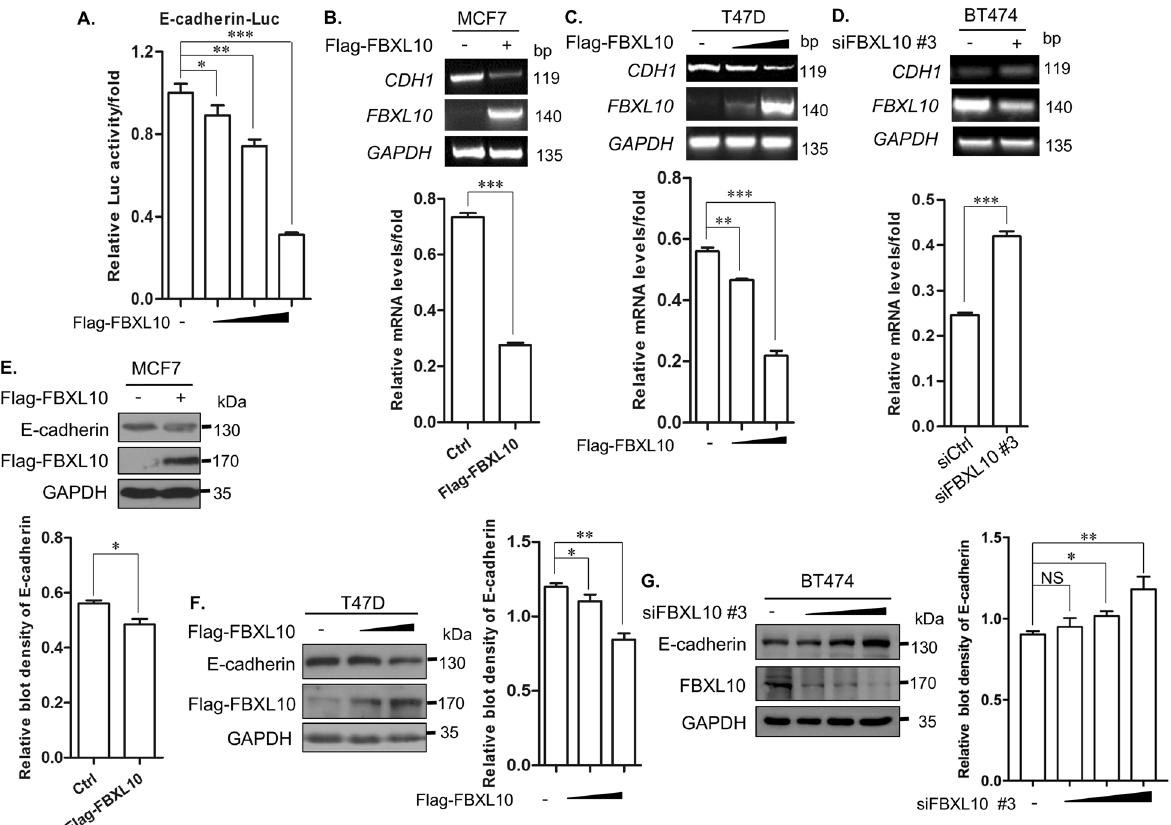
Fig. 3 FBXL10 inhibits the expression of E-cadherin in breast cancer cells. A Reporter gene assay showed the effect of FBXL10 overexpression on E-cadherin luciferase activity. B , C RT-PCR assay assessed the CDH1 mRNA levels with overexpression of FBXL10 in MCF7 ( B ) and T47D ( C ) cells. The bar graph below showed the relative intensity of CDH1 mRNA normalized by GAPDH . Data are means ± SD ( n = 3). ** P < 0.01; *** P < 0.001. D RT-PCR assay tested the effect of FBXL10 knockdown with siRNA on CDH1 mRNA levels in BT474 cells. The bar graph below showed the relative intensity of CDH1 mRNA normalized by GAPDH . Data are means ± SD (n = 3). *** P < 0.001. E , F Western blot assay was performed to evaluate the E-cadherin protein levels in MCF7 ( E ) and T47D ( F ) cells with FBXL10 overexpression. The bar graph showed the relative intensity of E-cadherin protein normalized by GAPDH. Data are means ± SD ( n = 3). * P < 0.05; ** P < 0.01. G Western blot assay evaluated the effect of siFBXL10 on E-cadherin protein levels in BT474 cells. The bar graph showed the relative protein density of E-cadherin protein normalized by GAPDH. Data are means ± SD ( n = 3). * P < 0.05; ** P < 0.01; NS means no signi fi cant